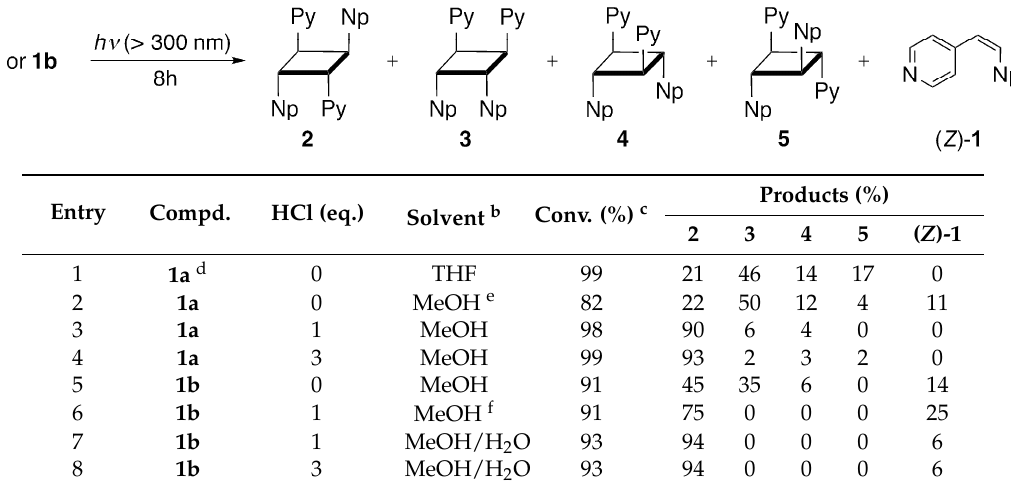
Table 1. UV irradiation of 1a and 1b . a